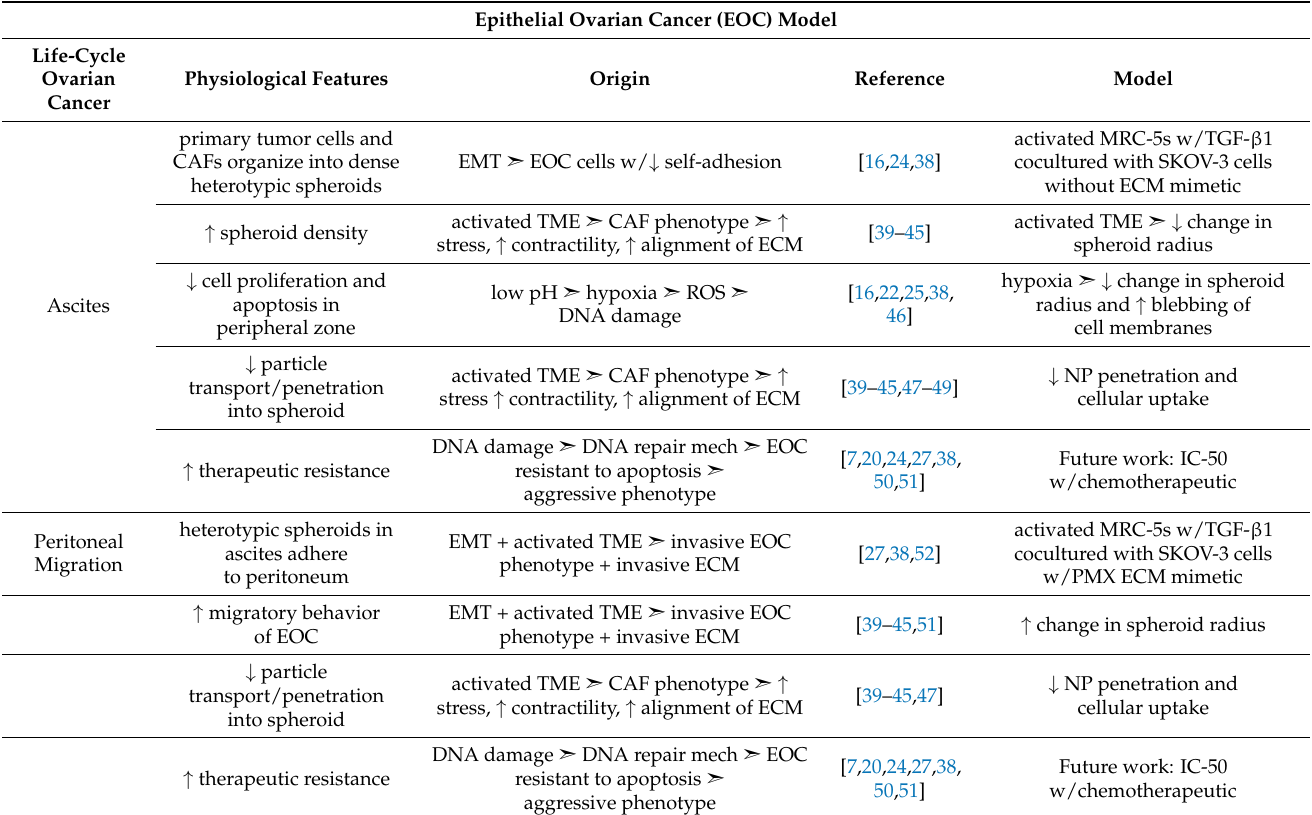
Table 1. Epithelial ovarian cancer (EOC) biphasic model. Description of the complex biochemical and physiologic changes involved in ovarian tumorigenesis, leading to resistance, and their representations in in vitro spheroid models. Ovarian cancer progression can be divided into two key stages based on tumor cell metastasis to the ascites and peritoneum. During both ascites and peritoneal invasion, the physiological features and their relevance to the pathophysiology of ovarian cancer metastasis were recapitulated in these in vitro models. An increase or decrease in tumor characteristics is denoted by “ ↑ ” and “ ↓ ”, respectively, while “ (cid:227) ” indicates a transition or induction of a given characteristic. Epithelial Ovarian Cancer (EOC)